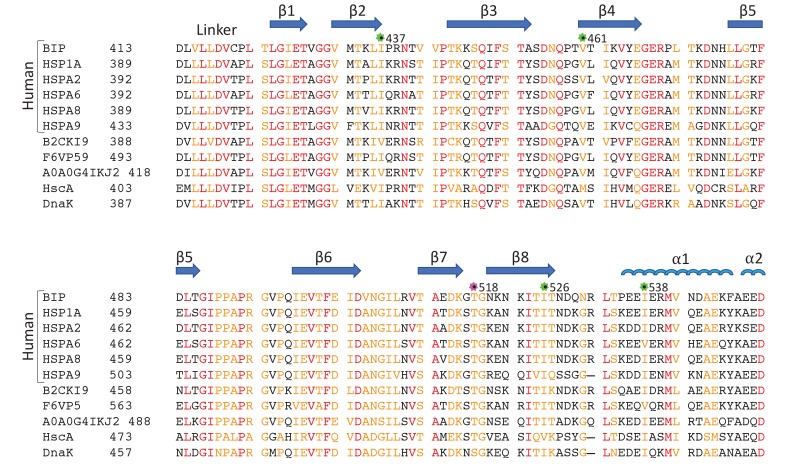
Sequence alignment of eukaryotic and bacterial Hsp70 proteins.The aligned sequences of the βSBD, including human HSP70s: BiP (GRP78 or HSPA5), HSP70 (HSPA1A or HSP72), HSPA2, HSC70 (HSPA8 or HSP73), HSPA9 (GRP75, Mortalin-2 or MTHSP70), and HSPA6; Hsp70s from eukaryotes: Stratiomys singularior (UniProt: B2CKI9), Plasmodiophora brassicae (UniProt: A0A0G4IKJ2) and Monodelphis domestica (UniProt: F6VP59); and bacterial Hsp70s: HscA and DnaK from Escherichia coli. Secondary structure elements are indicated above the protein sequence. The highly conserved residues are coloured in red, less conserved in orange, non-conserved in black. The positions of ‘soft mutations’ used in this study are indicated by green asterisks; the AMPylation site (Thr 518) is highlighted by a magenta asterisk.